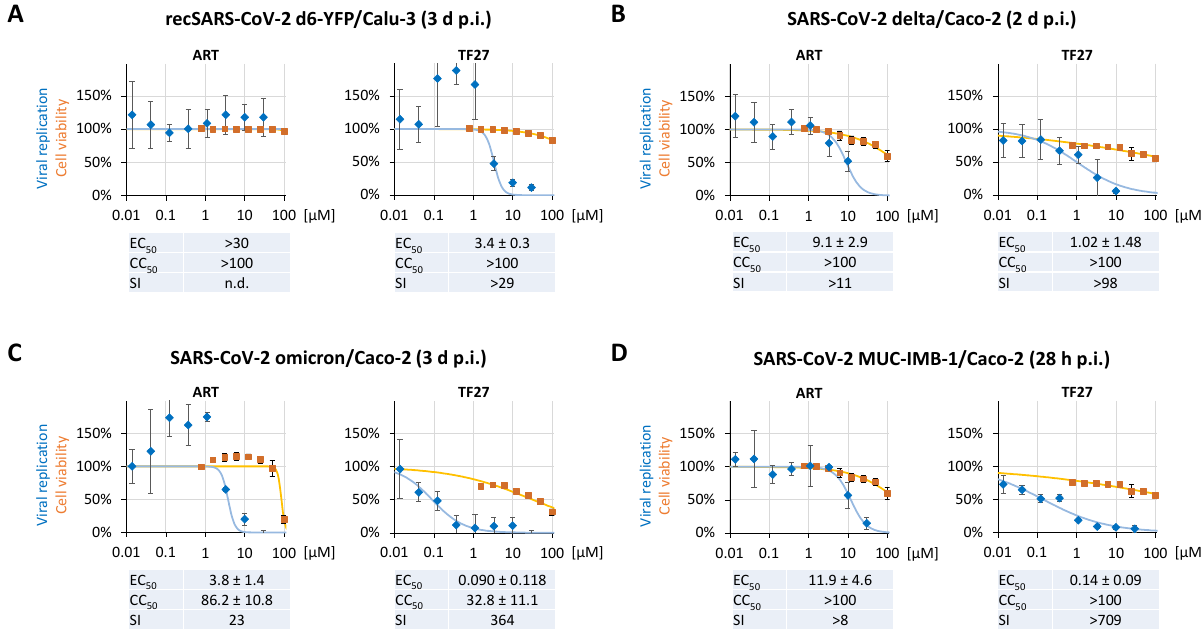
SARS-CoV-2 delta/Caco-2 (2 d p.i.)